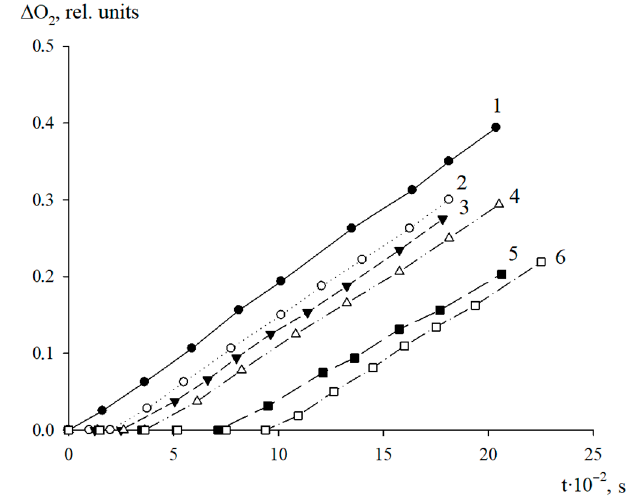
Figure 4. Typical kinetic curves of the oxygen uptake during the oxidation of 1,4-dioxane in the absence (1) and in presence of AO1 taken in concentrations, mol/l: 0.44·10 − 6 (2); 1.24·10 − 6 (3); 1.88·10 − 6 (4); 2.50·10 − 6 (5); 3.13·10 − 6 (6). T = 348K, V i = 1·10 − 7 M/s.